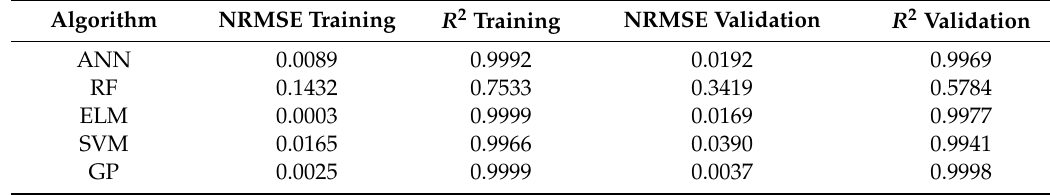
Table 7. Results of soft sensors for the training and validation